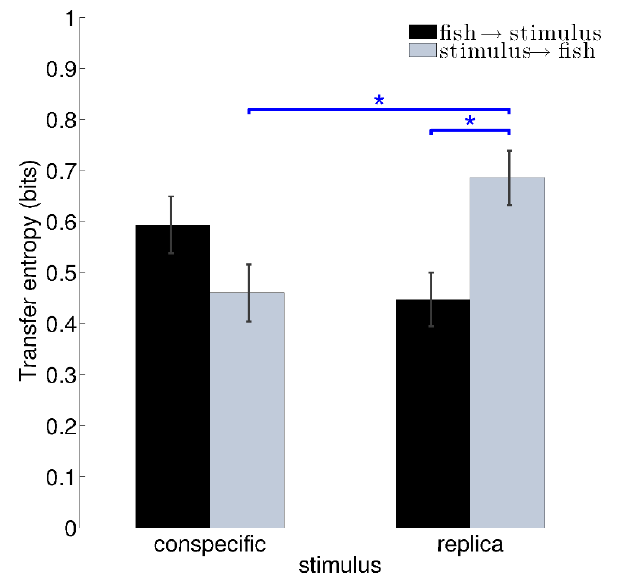
Figure 9 . Transfer entropy computation for experiments on the interaction between two live zebrafish (Conspecific) and between a zebrafish and a life-sized replica maneuvered by a robotic arm along pre-programmed trajectories (Replica). Error bars represent ± standard errors and overhead bars with an asterisk indicate statistically significant differences. [Reproduced from (Butail et al.,